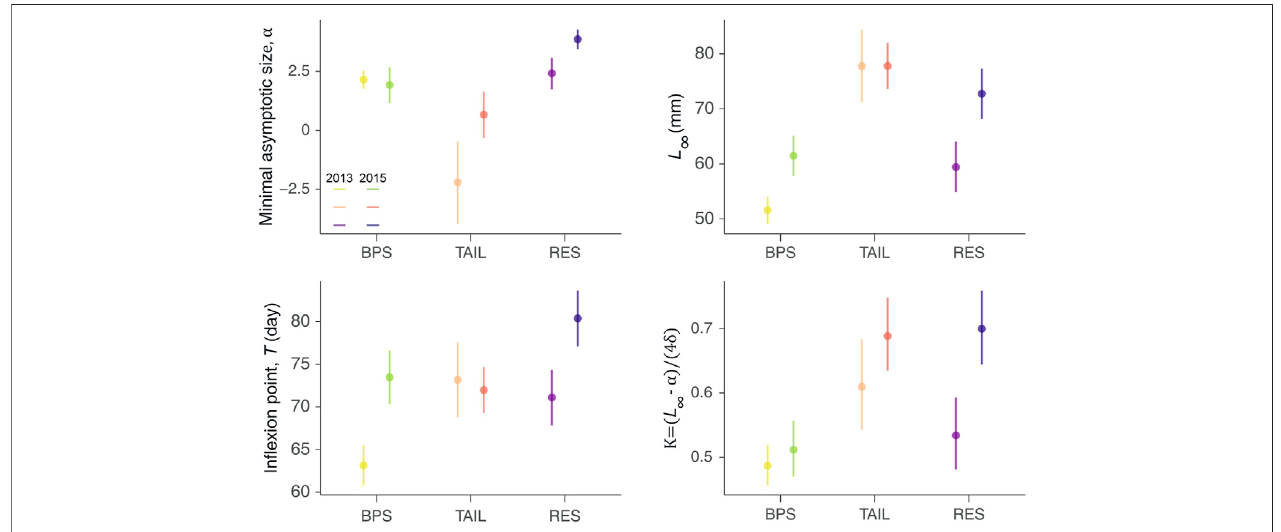
FIGURE 5 | Average values ( dots ) and their associated credible intervals (95%; vertical lines ) of the posterior distributions of the four parameters of the logistic growthcurves,persectionsandyear,withthemaximumasymptoticsize( L ∞ ),theminimalasymptoticsize( α ),thetimeatthein fl exionpoint( T ),andthemaximumgrowth rate ( K ).